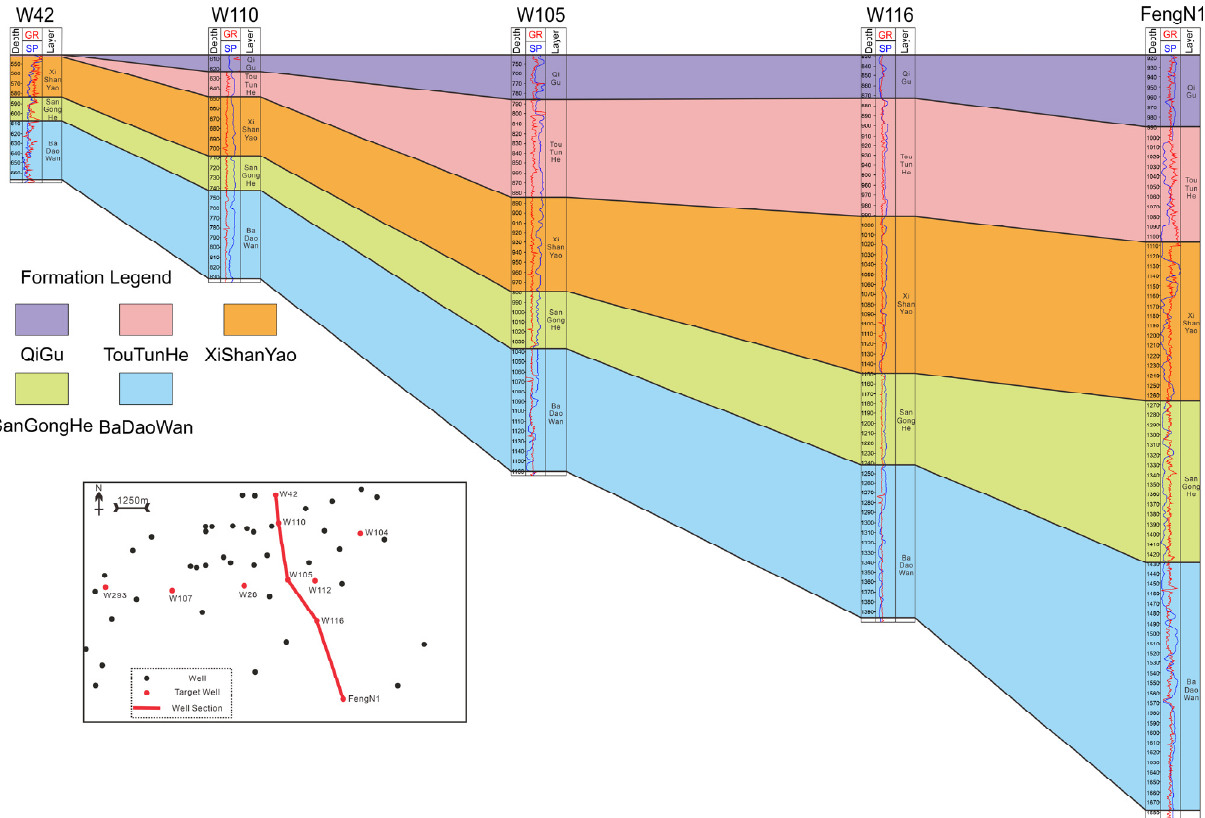
Figure 4. Stratigraphic correlation profile of north–south section.